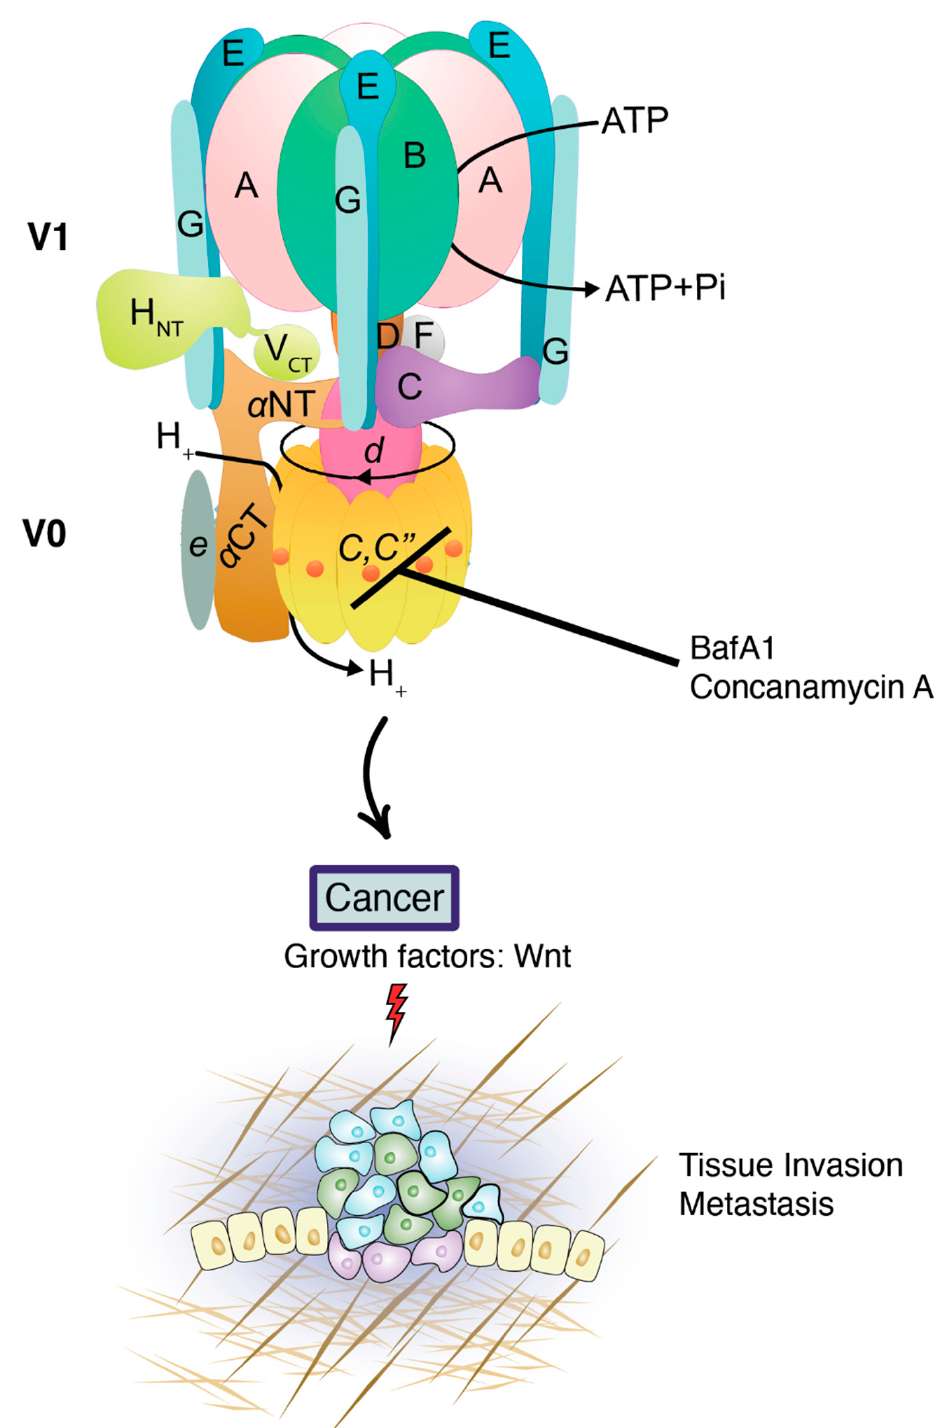
Figure 3. V-ATPases in cancer. The V-ATPase is formed of a peripheral V1 domain, which hydrolyzes ATP and an integral V0 domain that translocates protons. The subunits in the catalytic domain (V1) hydrolyze ATP at the cytosolic side of the membrane. The subunits embedded in the membrane form the proton-translocating domain (Vo) that transfers protons from the cytosol to the vesicle lumen. The effects of inhibiting lysosomal function with the specific vacuolar ATPase (v-ATPase) inhibitors such as BafA1 was reported to result in significantly decreased tumor growth, proliferation, and metastasis through the activation of signaling pathways such as Wnt in several types of cancer.